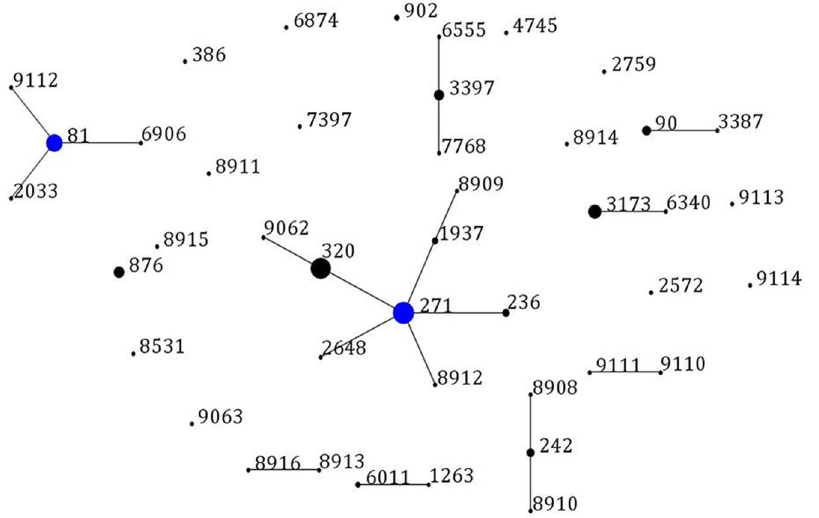
Figure 2. Population snapshot of 174 S.pneumoniae isolates. One spot represents a single ST. The size of the circle corresponds to the number of isolates belonging to a ST. The lines indicate the presence of single locus variant (SLV) links among particular STs. Blue spots indicate the founder of a clonal complex.